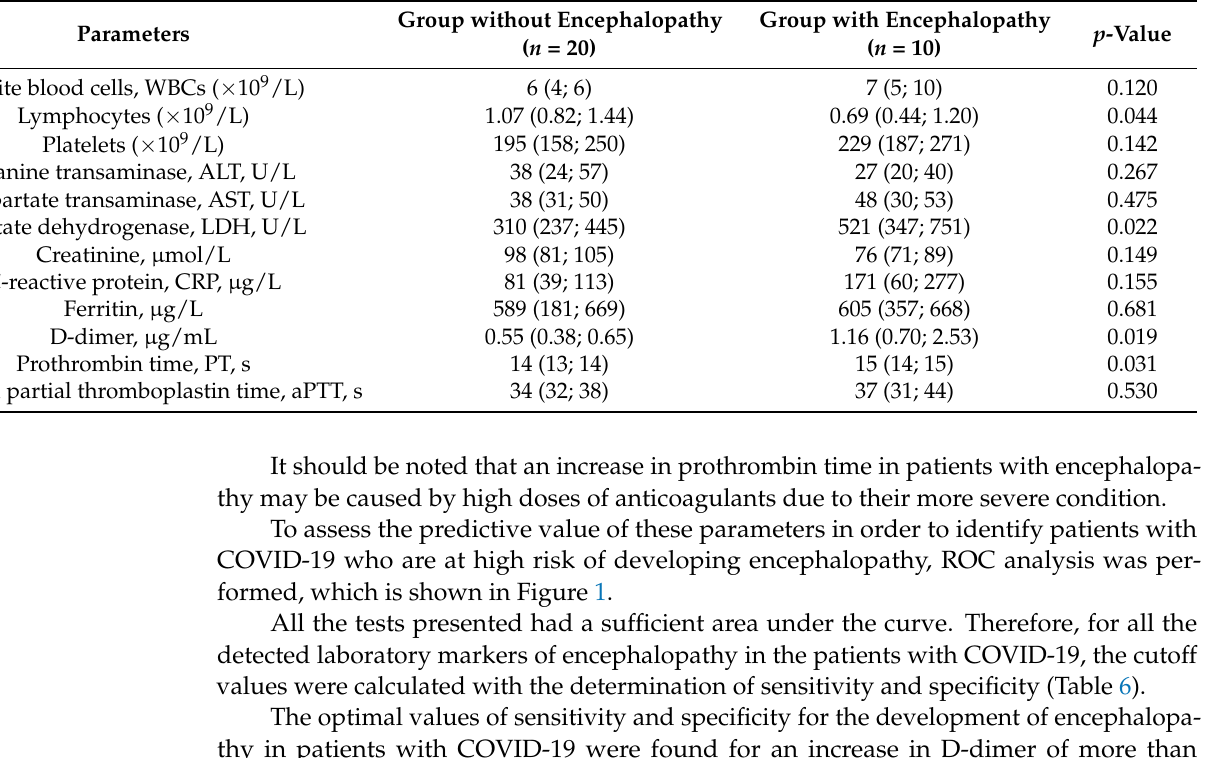
Table 5. Comparison of laboratory parameters in the studied